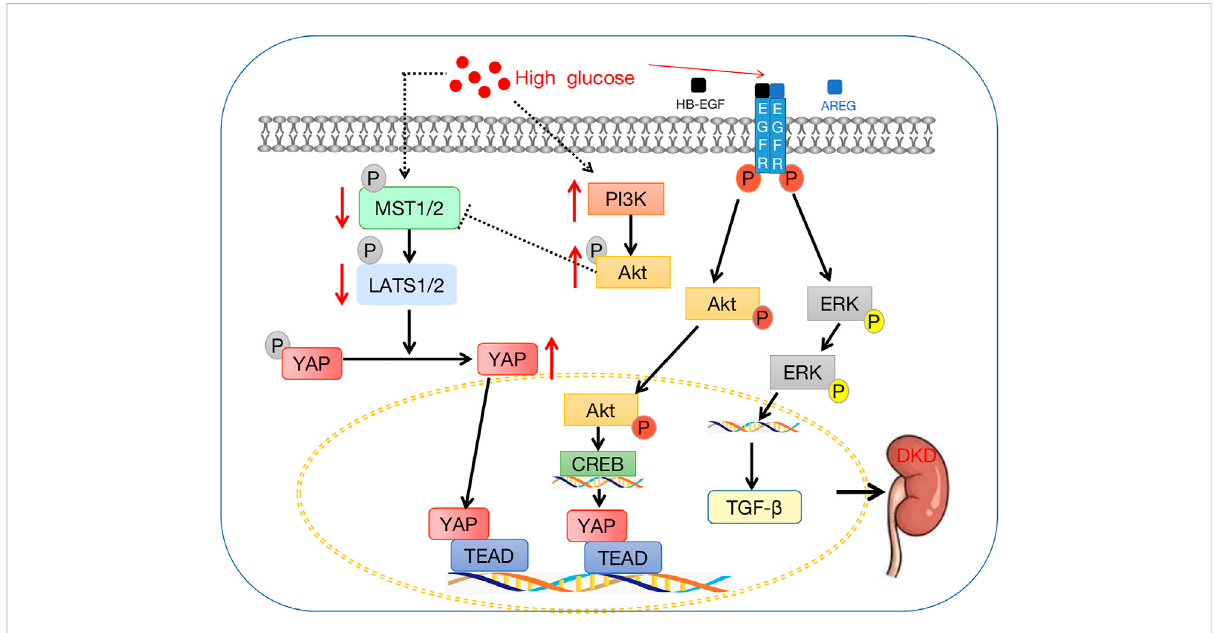
CrosstalkbetweentheHipposignalingpathwayanddiabetickidneydisease.ThedownstreameffectorfactorYAPentersthenucleus,bindswith TEAD, and then affects the downstream target gene CTGF to promote the occurrence and development of